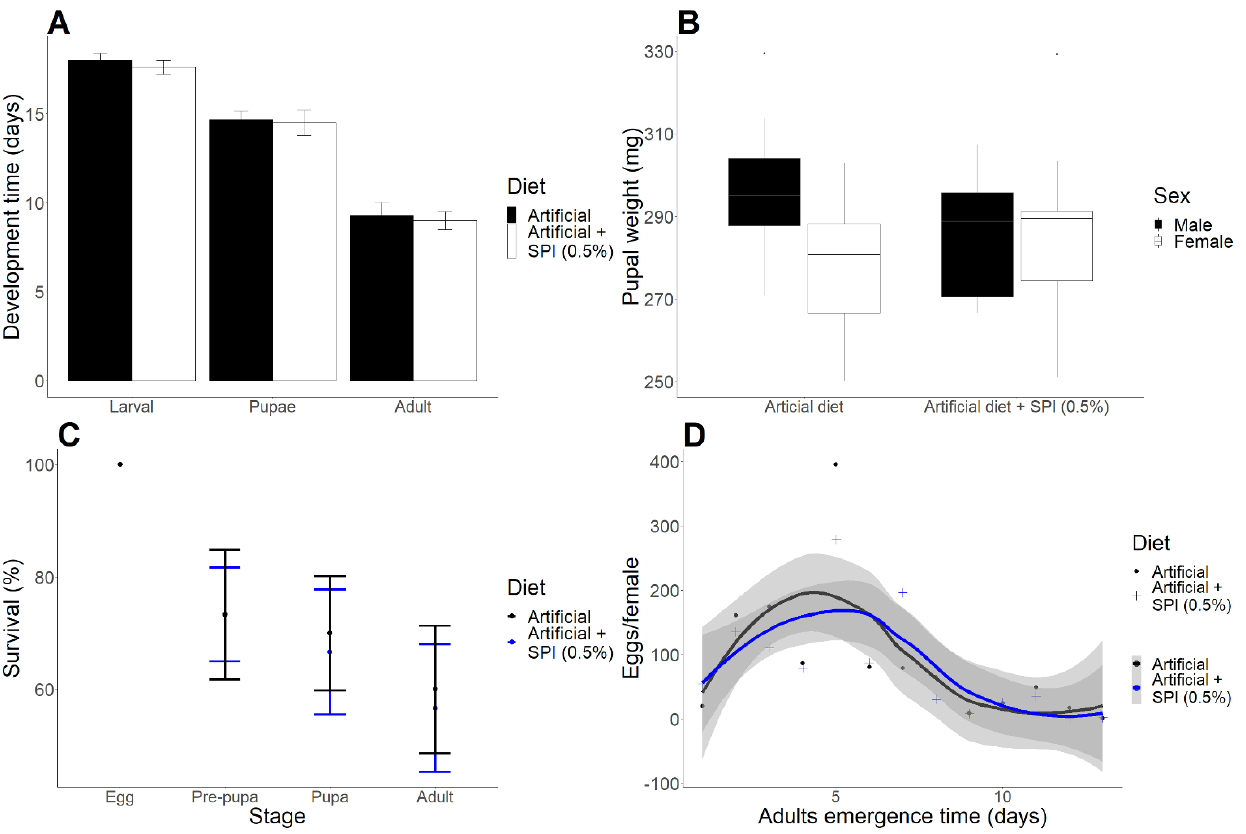
Figure 1. Influence of diet supplemented with SPIs (0.5%) on development time ( A ), pupal weight ( B ), survival ( C ) and number of eggs per female ( D ) of H. armigera . Error bars represent standard error ( A – C ). The shadings in ( D ) indicate 80% confidence intervals.